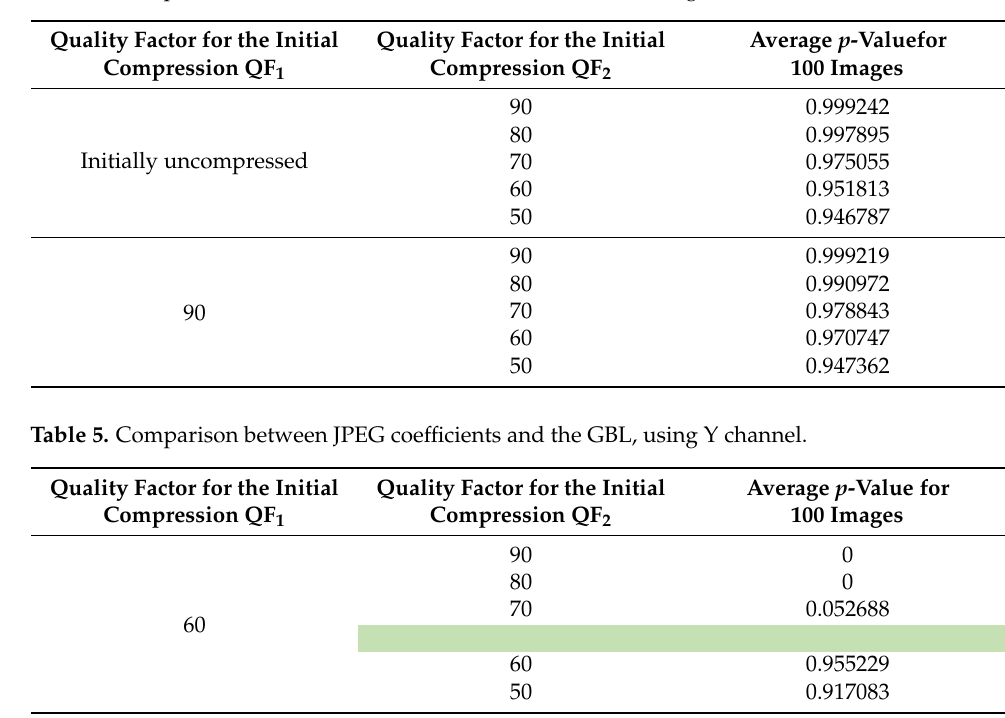
Table 4. Comparison between JPEG coefficients and the GBL, using Y channel.